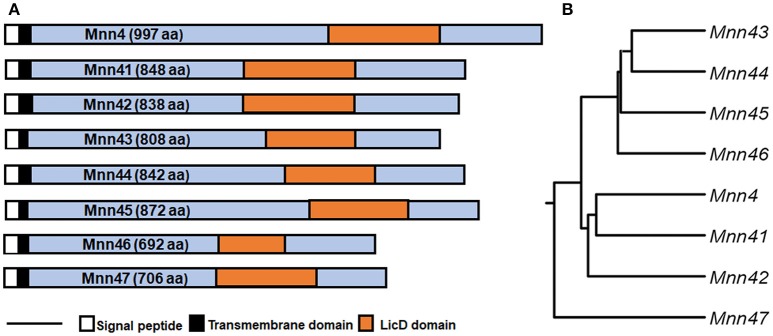
Phylogenetic tree of members of the C. albicans MNN4-like gene family. (A) The eight members of the MNN4-like gene family, indicating relevant features of the primary amino acid sequences. The scale bar represents 100 amino acids (B), Dendrogram generated using the Neighbour-joining tree without distance correction algorithm defining three clades, (i) Mnn43, Mnn44, Mnn45 and Mnn46; (ii) Mnn4, Mnn41 and Mnn42; and (iii) Mnn47 as a sole outlier. The amino acid sequences were retrieved from http://www.candidagenome.org, archived under the following systematic names: MNN4 (C4_06540W_A), MNN41 (C2_03710W_A), MNN42 (C2_03690C_A), MNN43 (C1_02670C_A), MNN44 (C1_02680C_A), MNN45 (C6_02830W_A), MNN46 (C4_06990W_A), MNN47 (C1_09130W_A).